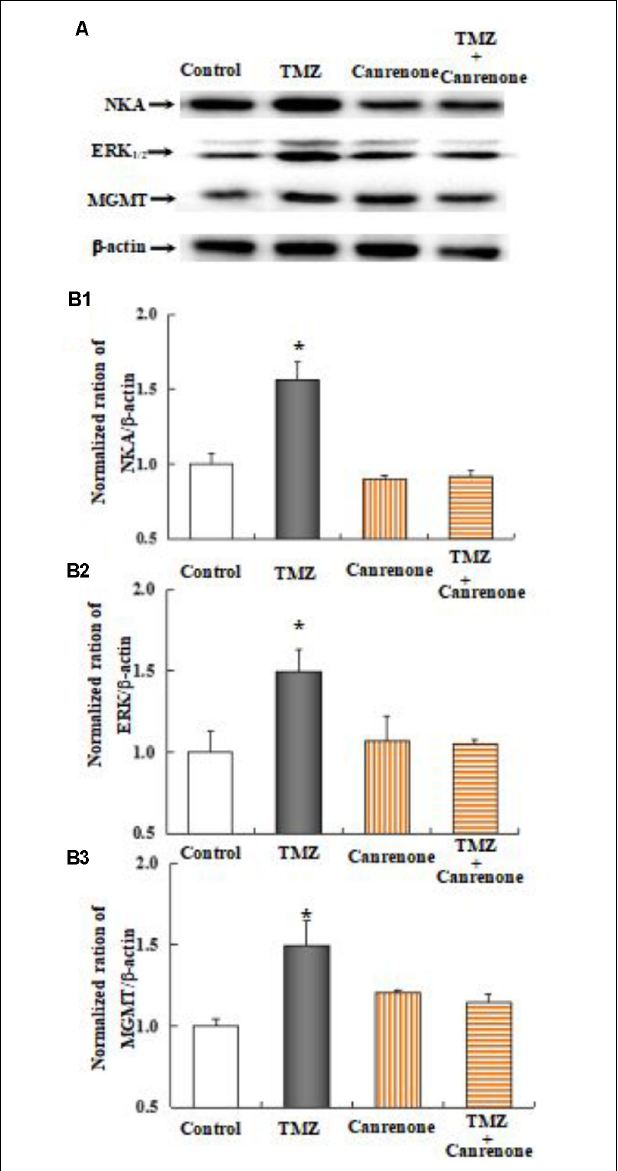
FIGURE 11 | Upregulation of TMZ-induced ERK 1 / 2 and MGMT expression by activation of Na,K-ATPase in U251 cells. (A) Cells were incubated for 48 h in the absence of any drug (Control) or in the presence of 5 µ M TMZ. In some experiments 10 µ M Canrenone, an inhibitor of Na,K-ATPase, was added 4 h before the addition of TMZ. (B1) Average mean expression was quantified as ratios between Akt and β -actin. (B2) Mean ERK 1 / 2 expression was quantified as ratios between ERK 1 / 2 and β -actin. (B3) Mean MGMT expression was quantified as ratios between MGMT and β -actin. Similar results were obtained from three independent experiments. SEM values are indicated by vertical bars. ∗ Indicates a statistically significant ( P < 0.05) difference from the negative control